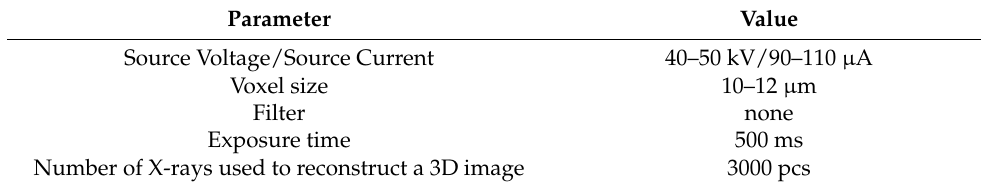
Table 2. X-Ray CT test